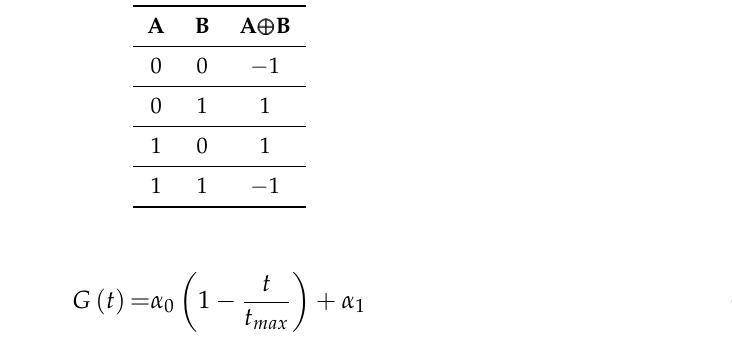
Table 1. Truth table for an exclusive or (XOR)